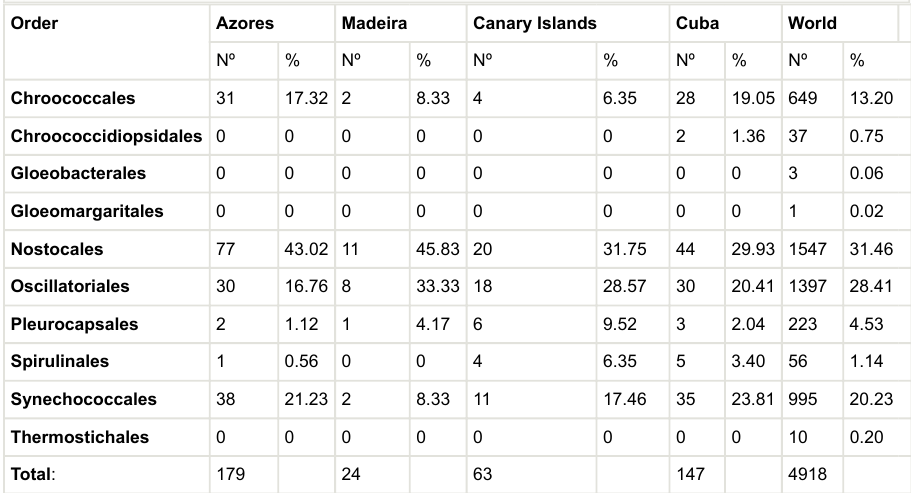
Cyanobacteria species richness in the Azores compared to world-known species richness (World's order and species number retrieved from Guiry and Guiry (2022); Canary Islands, Madeira and Cuba numbers retrieved from Cordeiro et al.